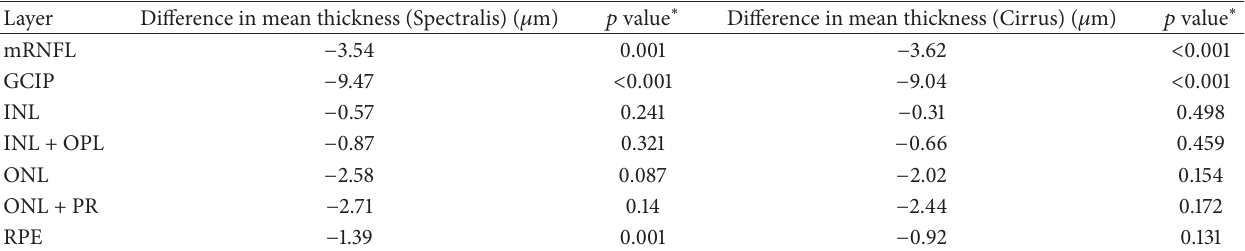
Table 5: Cross-sectional comparison of retinal layer thickness between HCs and MS